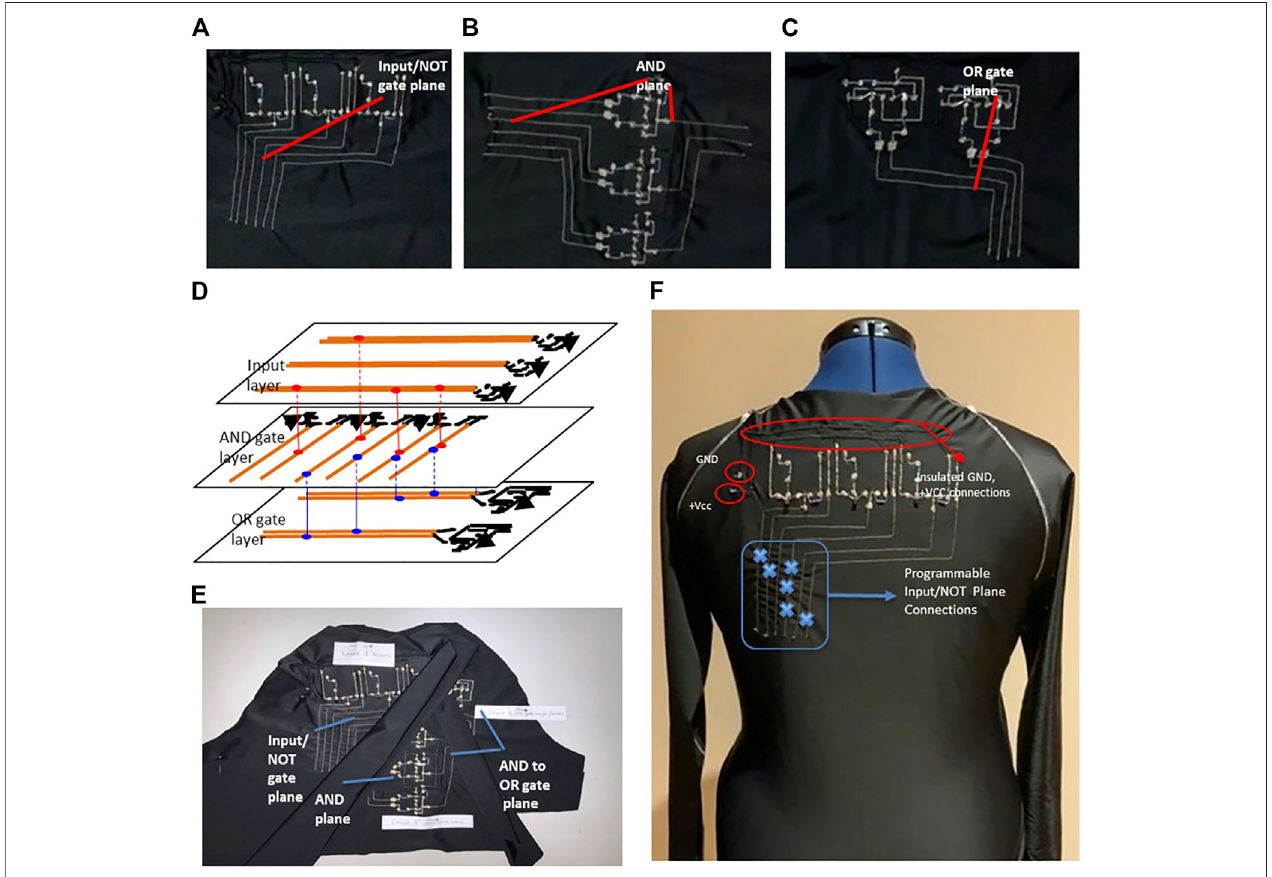
FIGURE 7 | Multilayered PLA smart garment: (A) Input/NOT embroidered logic gate cluster and plane, (B) AND embroidered logic gate cluster and plane, (C) OR logic gate cluster and plane, (D) multilayered (3-layered) plane interconnected approach, (E) multilayered — three-layered fabric approach, and (F) multilayered PLA garment